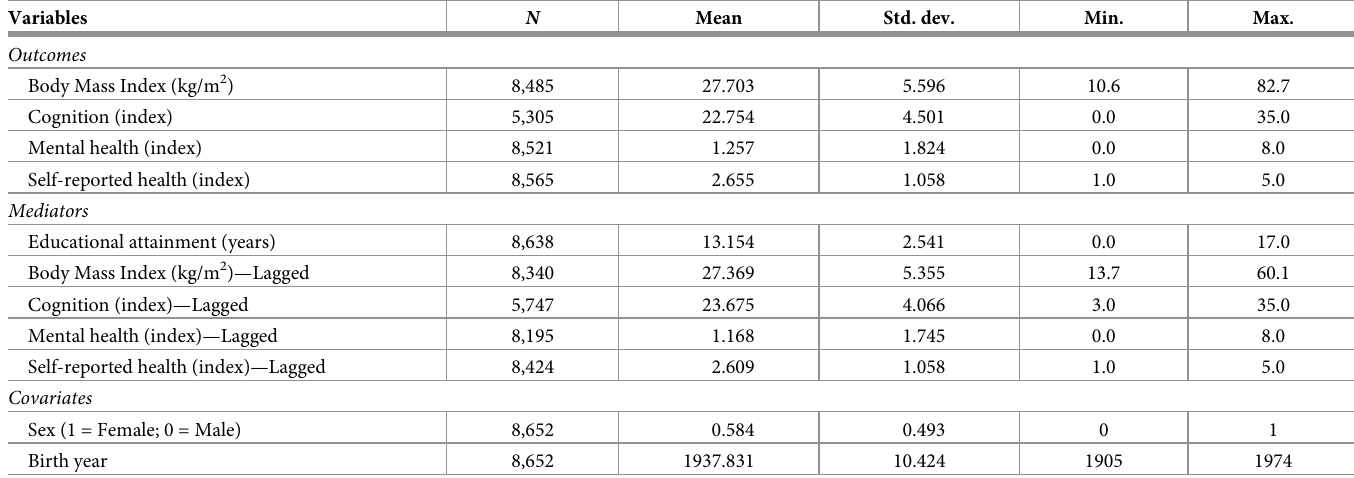
Table 3. Descriptive statistics of the analysis sample from the Health and Retirement Study. Std. dev. = Standard deviation; Min. = Minimum; Max. = Maximum. Variables N Mean Std. dev. Min.